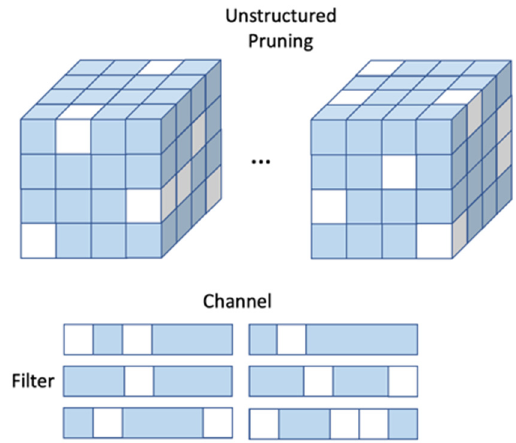
Figure 1. Example of unstructured pruning.